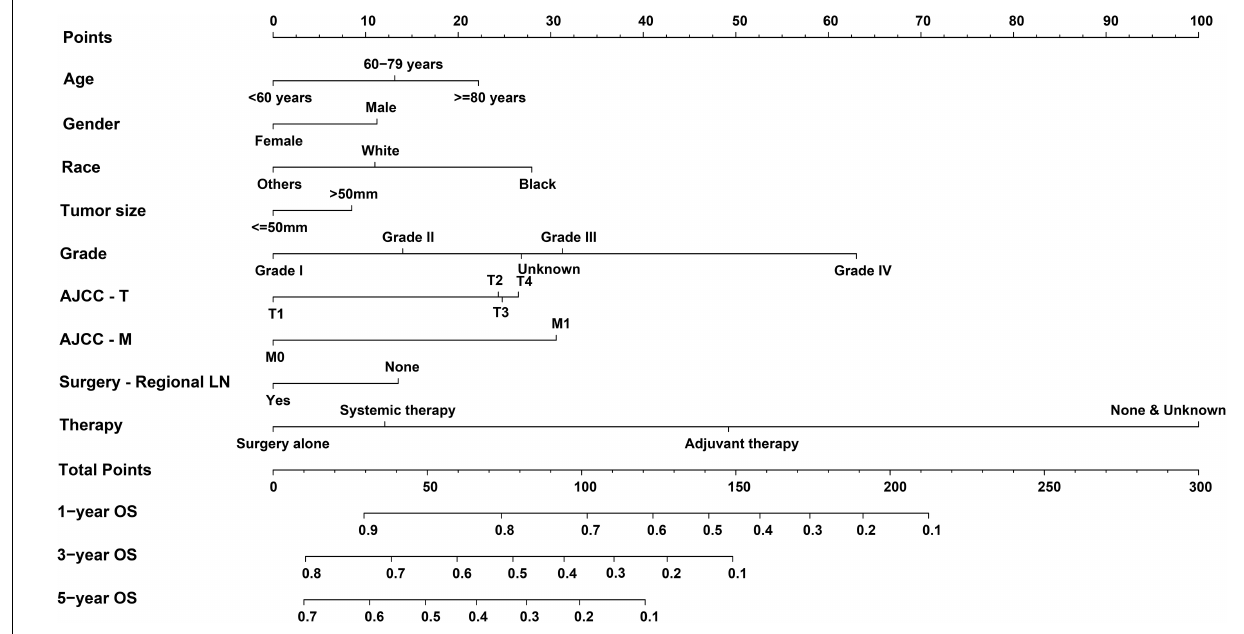
FIGURE 7 | Nomogram for predicting OS of patients with ICCA.